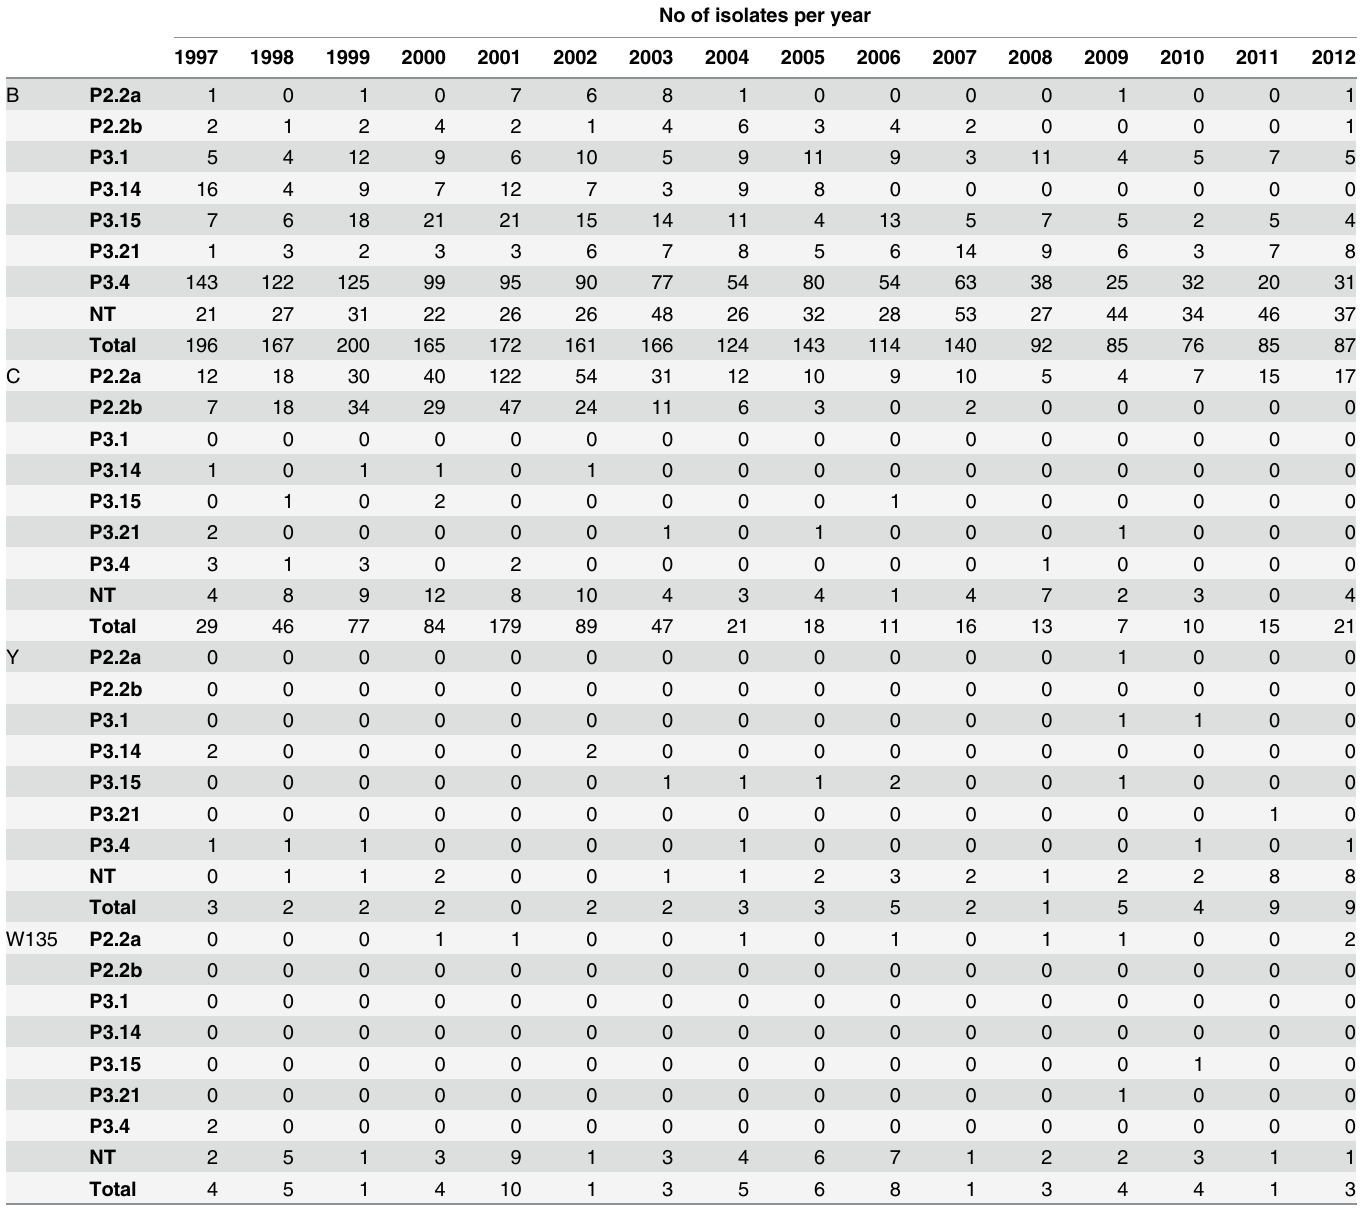
Table 2. Number of invasive meningococcal isolates in Belgium per serotype, 1997 –